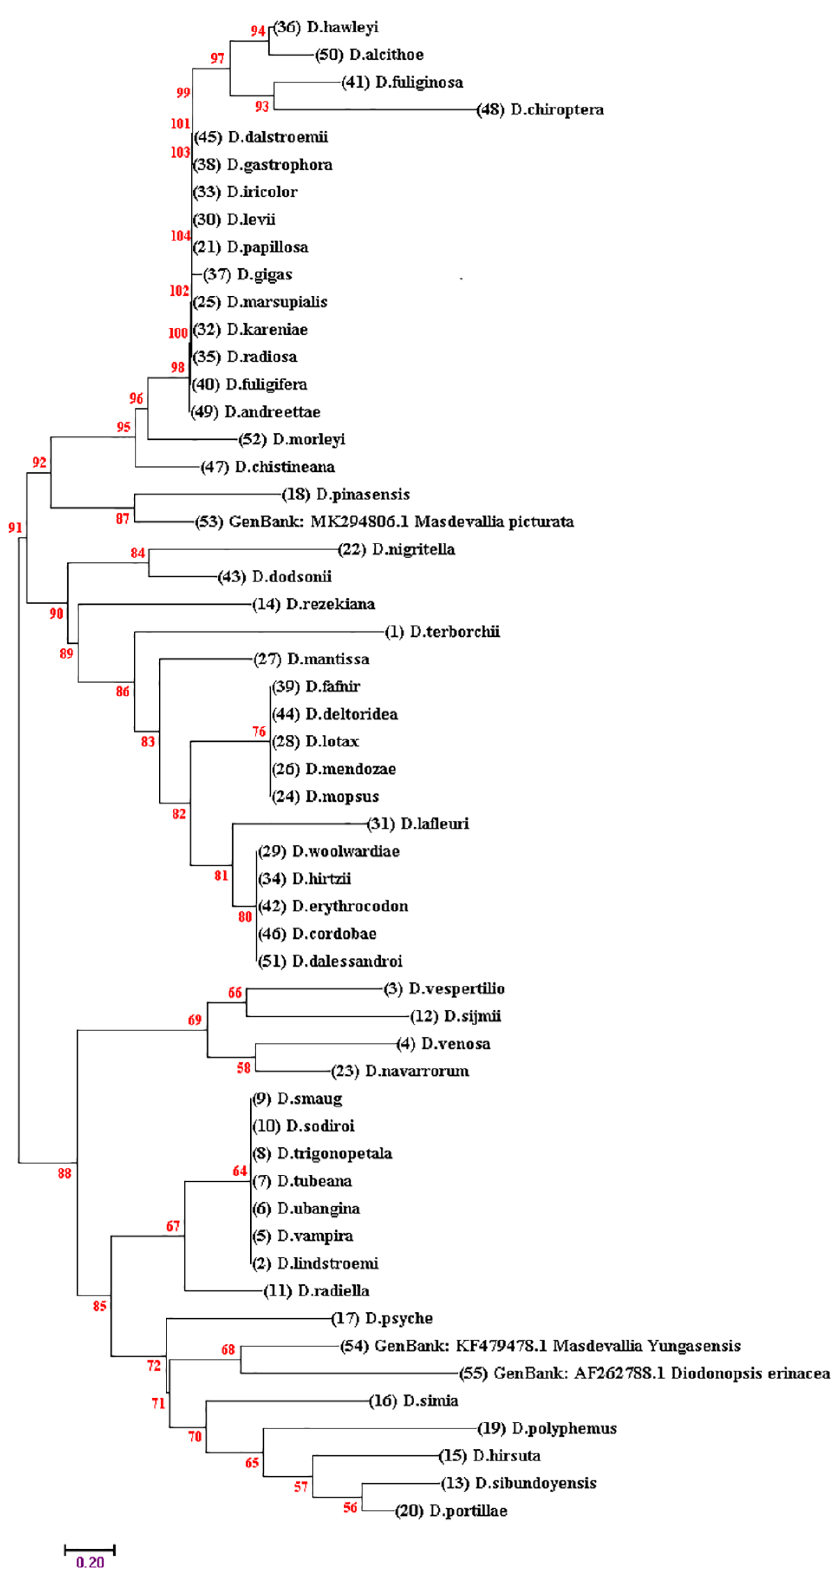
Figure 2. Phylogenetic tree of Dracula species based on the DNA sequencing data of the ITS